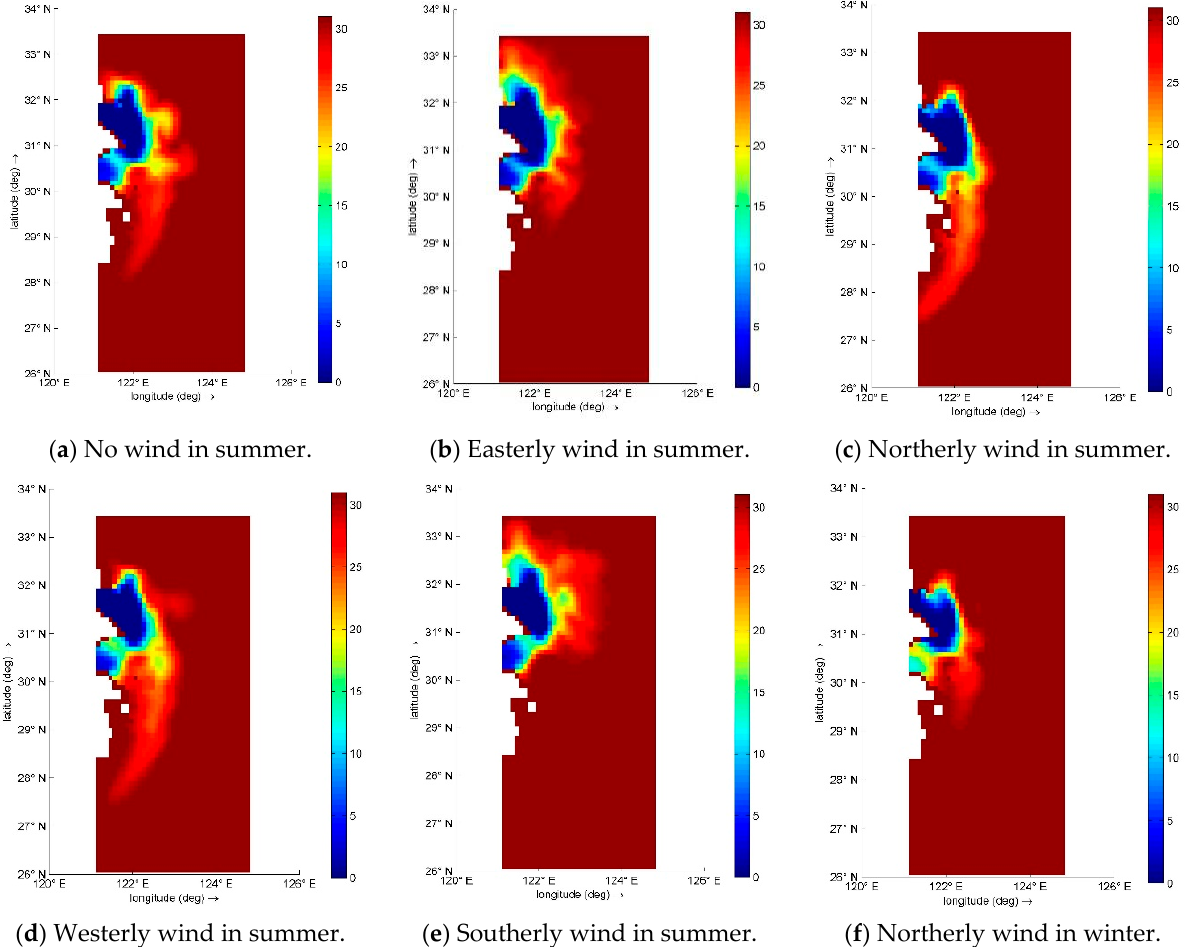
Figure 11. Water diffusion in the Yangtze River delta under no wind ( a ), easterly wind ( b ), northerly wind ( c ), westerly wind ( d ), and southerly wind ( e ) in summer and northerly wind ( f ) in winter (unit: ppt).